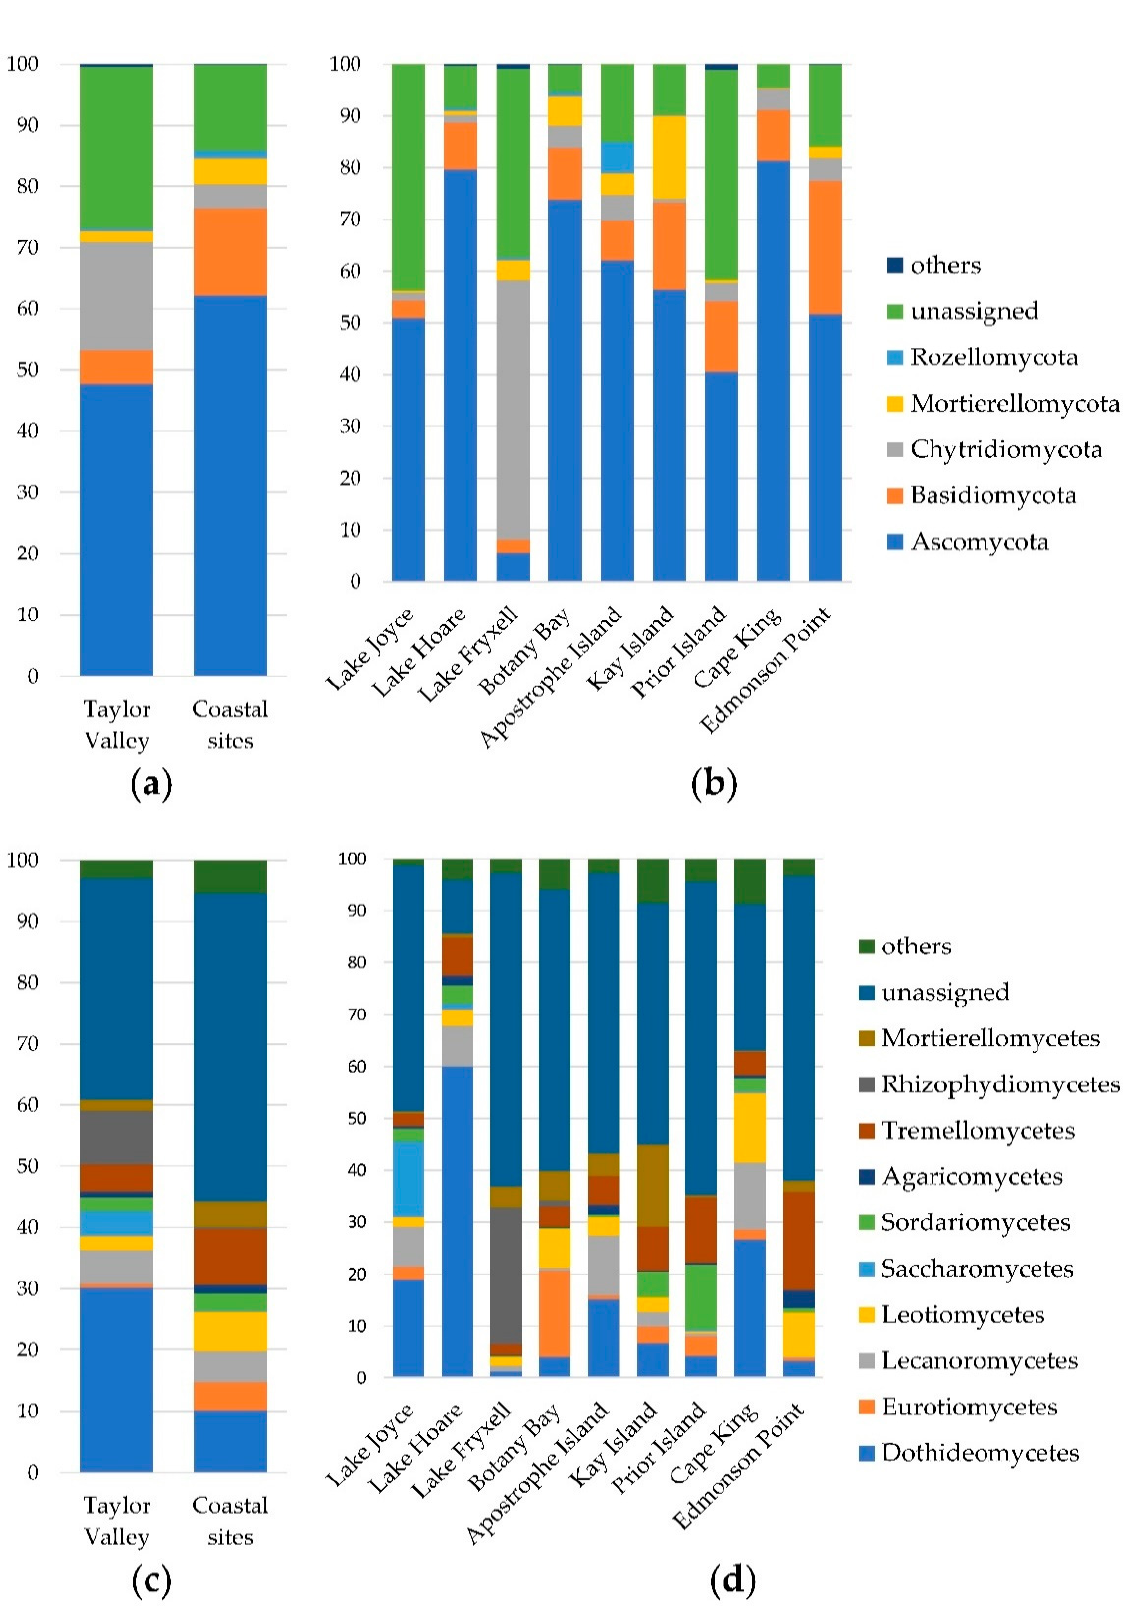
Figure 3. Taxonomic composition at phylum and class level. The different panels represent: ( a ) the distribution of reads at phylum level in the two different environments (Taylor Valley and coastal sites) and ( b ) in the different sampling localities, and at class level ( c ) in the two different environments (Taylor Valley and coastal sites) and ( d ) in the different sampling localities.